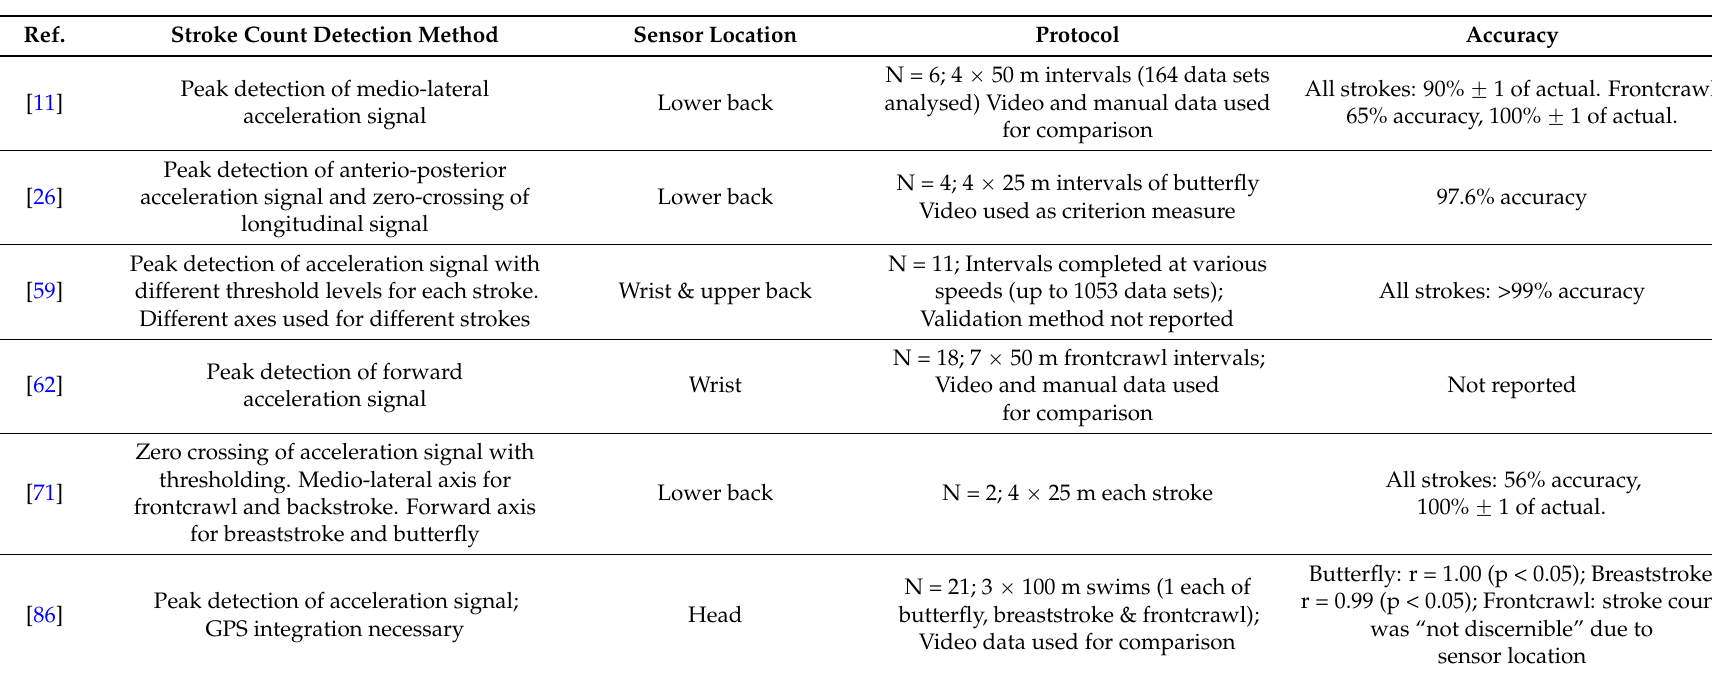
Table 4. Details of various methods used for the detection of stroke count using inertial sensor devices, with validation methods and reported detection accuracy.